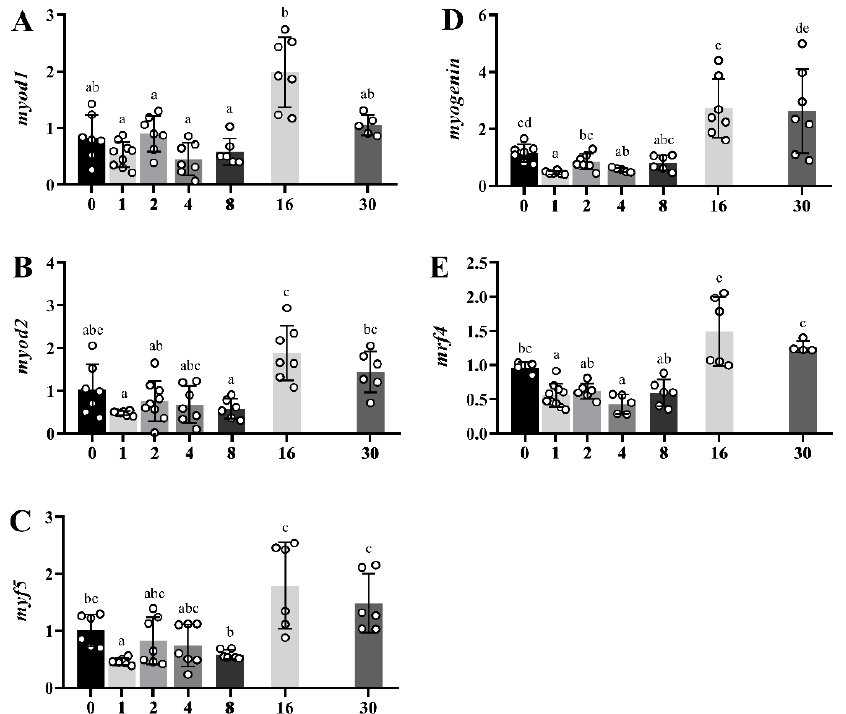
Figure 7. Bar plots of relative gene expression of myod1 ( A ), myod2 ( B ), myf5 ( C ), myogenin ( D ) and mrf4 ( E ) along the regeneration experiment in white skeletal muscle from day 0 (time of injury) to day 30. White-filled circles represent individual relative gene expression values. Data are presented as means ± SEM ( n = 10). Different letters indicate significant differences ( p < 0.05).